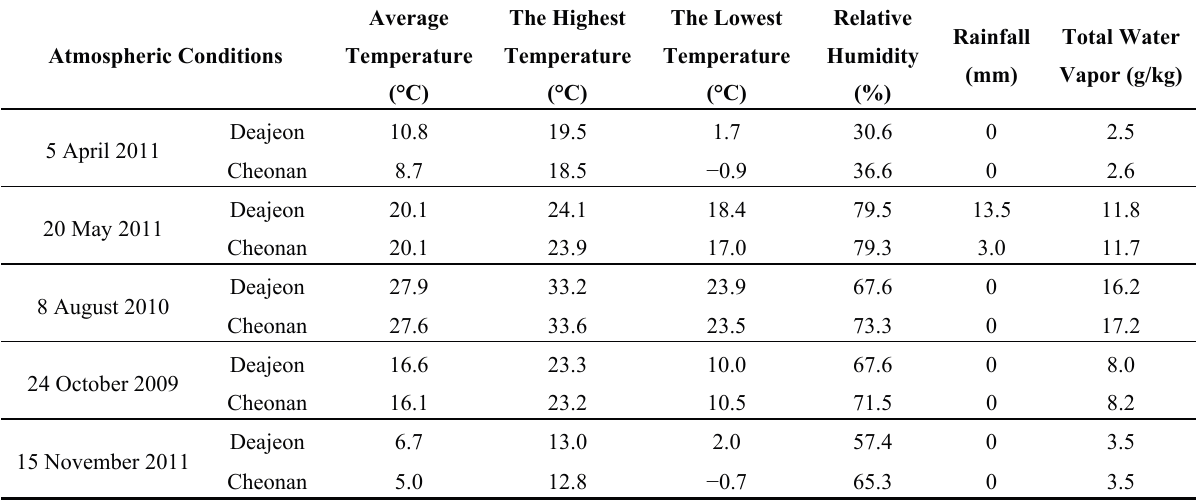
Figure 1. ( a ) Location of the study area, the Gongju and Sejong regions, South Korea; ( b ) locations of field survey (green star) and meteorological stations (black triangle); ( c ) design of NFI plot consisting of 4 sub-plots. Table 1. Atmospheric conditionson date of image acquisition from 2 nearest meteorological